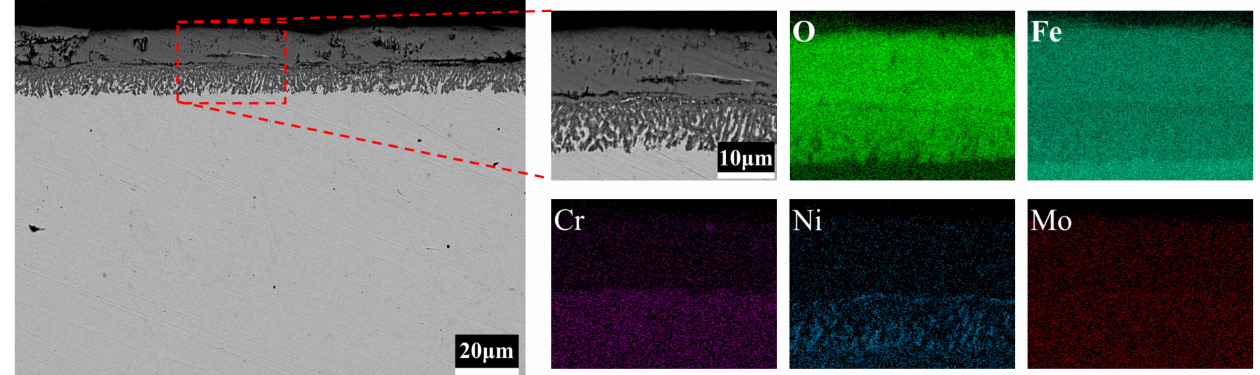
Figure 7. BSE-EDS maps of 3CrNi3Mo steel